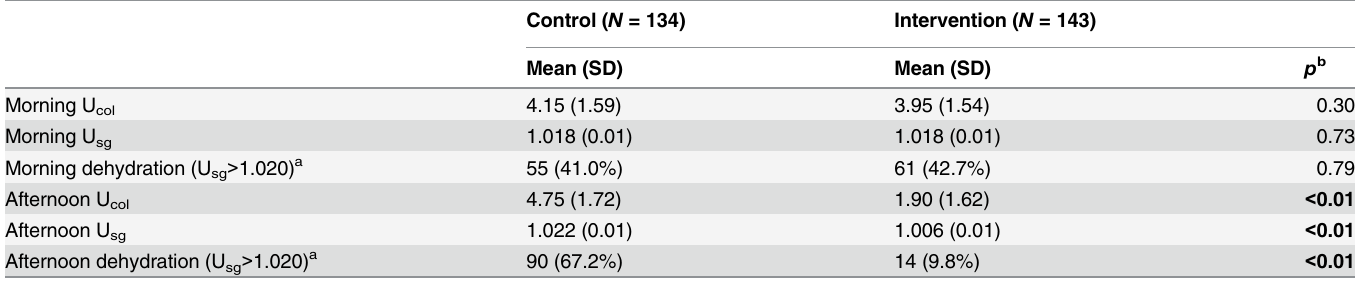
Table 3. Hydration status by study